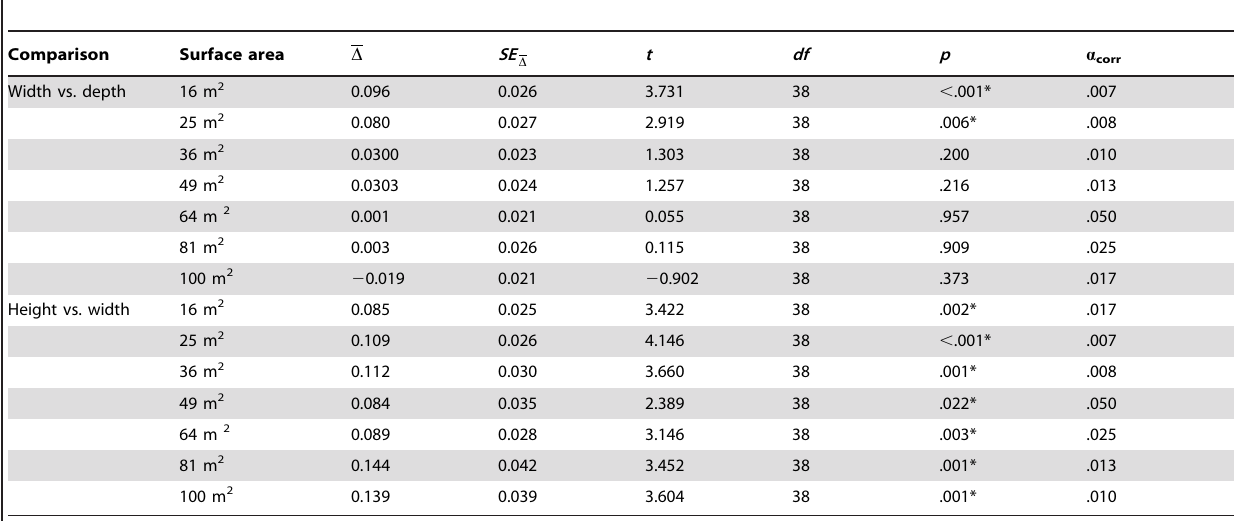
Table 5. Experiment 2: Results of the paired-samples t-tests (test value=0) conducted for the difference of the relative estimation errors in the comparisons width vs. depth and height vs. width, differentiated according to the seven levels of surface area.